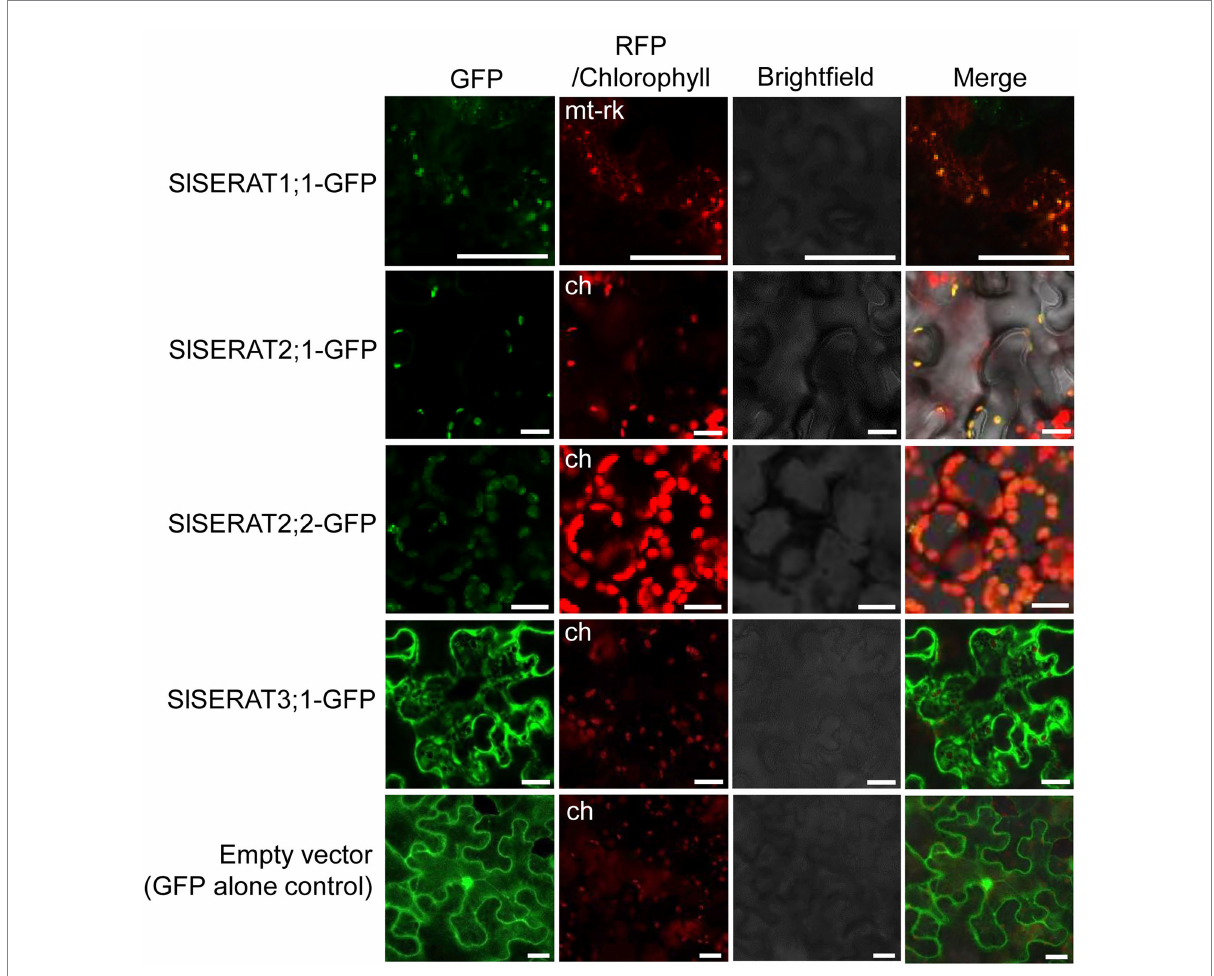
FIGURE 3 Subcellular localization of the tomato SERAT proteins. For SlSERAT1;1, the mitochondrial marker (mt-rk, RFP fusion) was used to indicate the position of mitochondria. For SlSERAT2;1 and SlSERAT2;2, the autofluorescence of the chloroplasts (ch) corroborated their chloroplast localization. The signals of SlSERAT3;1 spread all over the cytoplasm. GFP in the empty vector was expressed all over the cell, and the signals could be spotted in the plasma membrane, the cytoplasm, and the